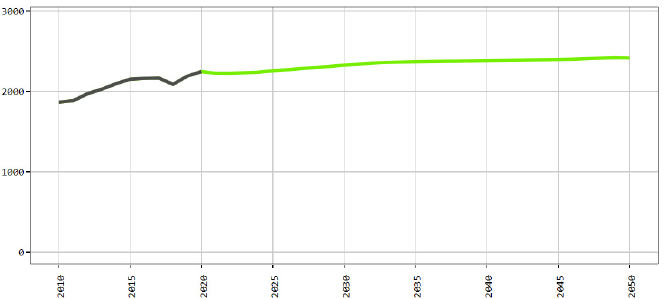
Figure 24. GHG emissions in Latvia in 2010–2020, with a projection for 2021–2050, thousands of tons CO 2 equivalent